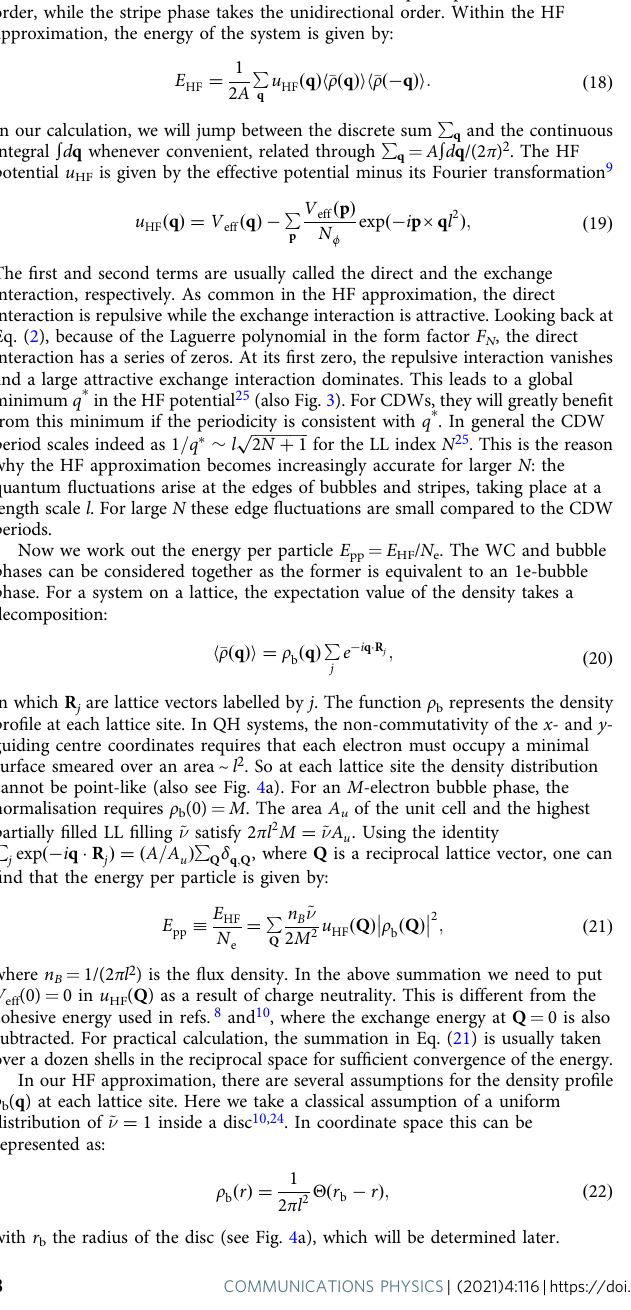
geometry: visualisation of the DMRG data for the density pro fi le of 2 electron bubble crystal at 2/7 fi lling and the isotropic